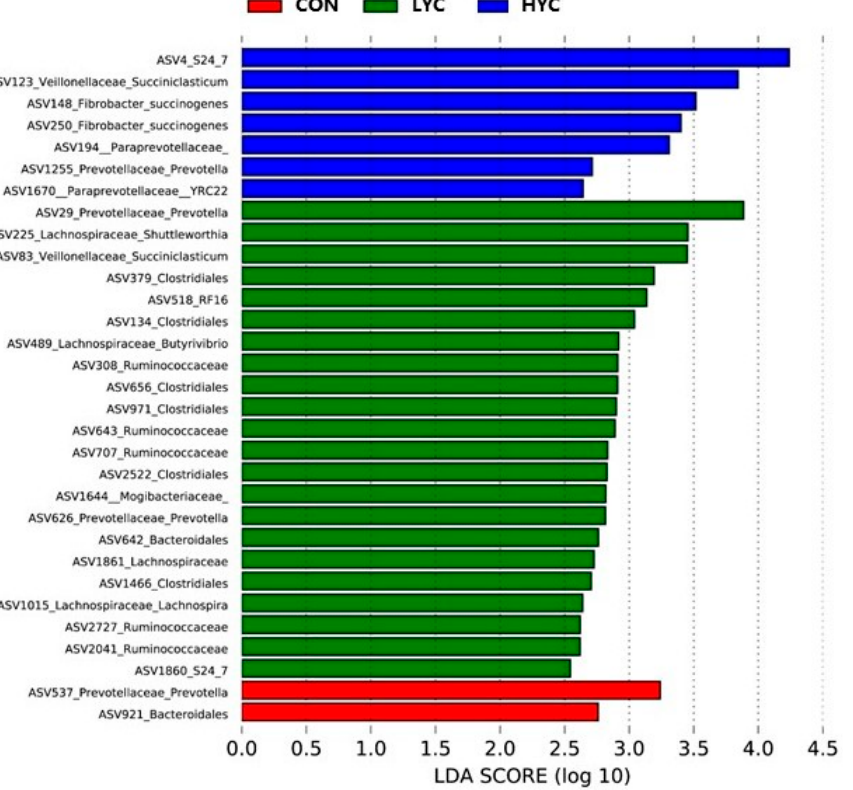
Figure 4. The featured bacteria identified by LEfSe analyses. CON, control (basal diet supplied with 0 g/d yeast culture at the whole stage); LYC, low dose yeast culture (basal diet supplied with 10 and 20 g/d yeast culture at the early and late stages, respectively); HYC, high dose yeast culture (basal diet supplied with 20 and 40 g/d yeast culture at the early and late stages, respectively). ASVs in this figure was significant ( p < 0.05) and had an LDA Score > 2, which was considered a significant effect size.